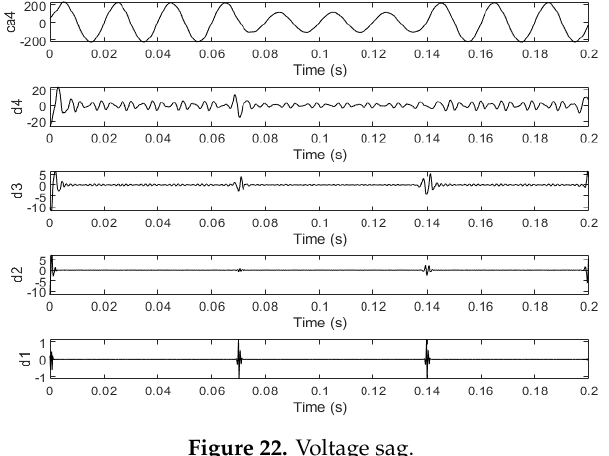
Figure 22. Voltage sag.